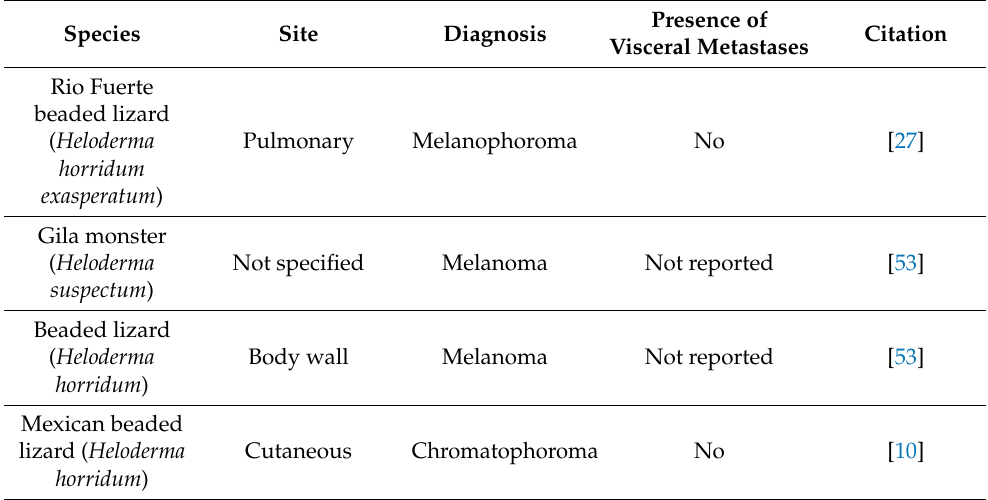
Table 5. Clinical features of chromatophoromas in the reptile family: Helodermatidae . Species